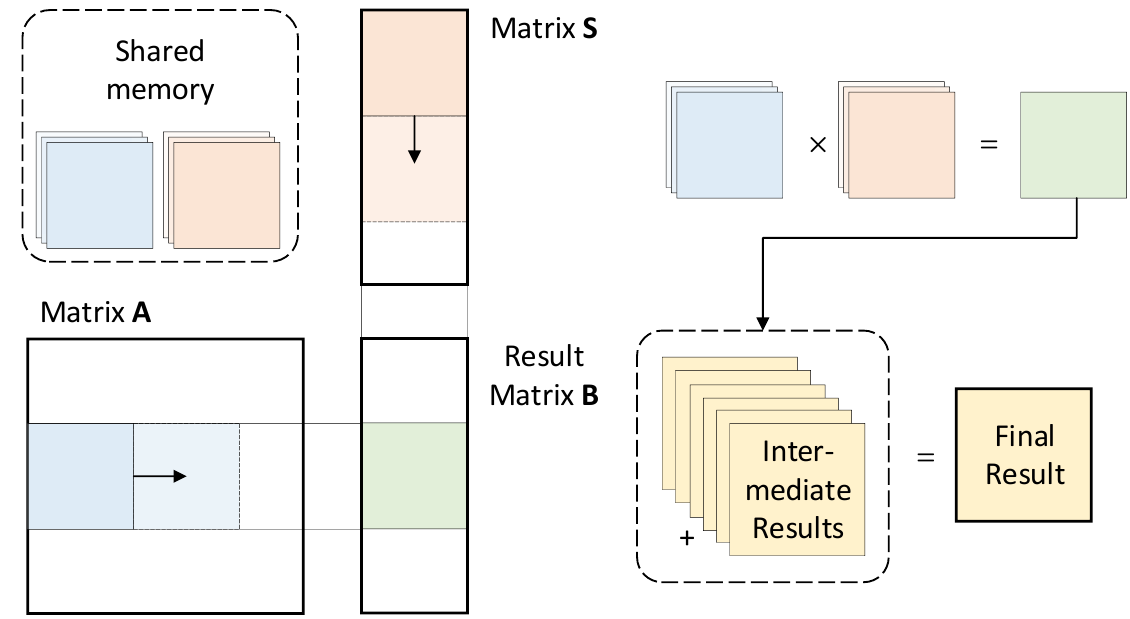
Figure 5. Parallel matrix product